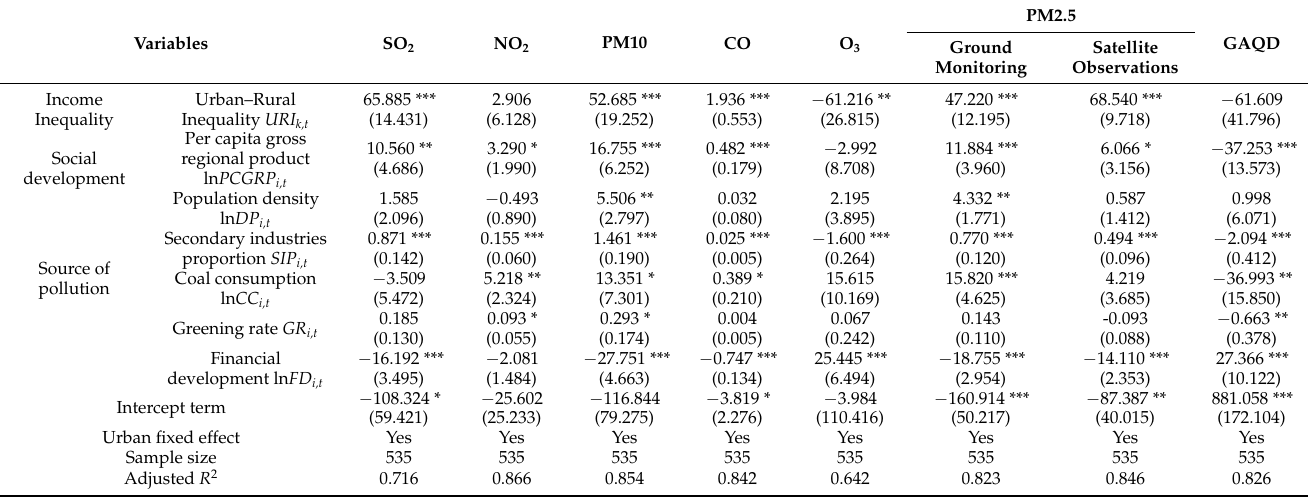
Table 4. Regressions analysis for air pollution and income